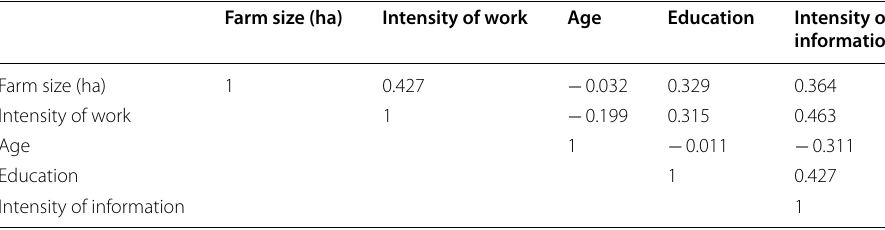
Table 4 Correlations between socio-structural